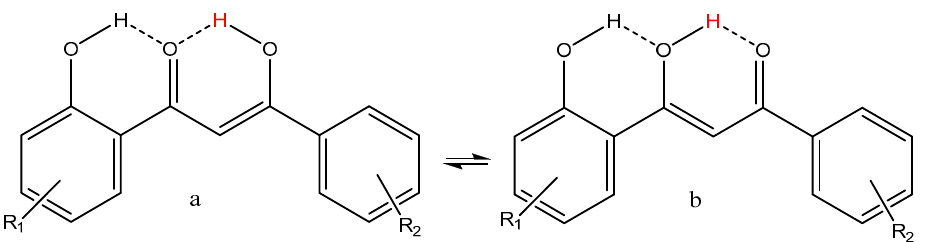
Figure 11. 1-(2-Hydroxyphenyl)-3-phenyl-1,3-propanedione ( o -hydroxydibenzoylmethane). For